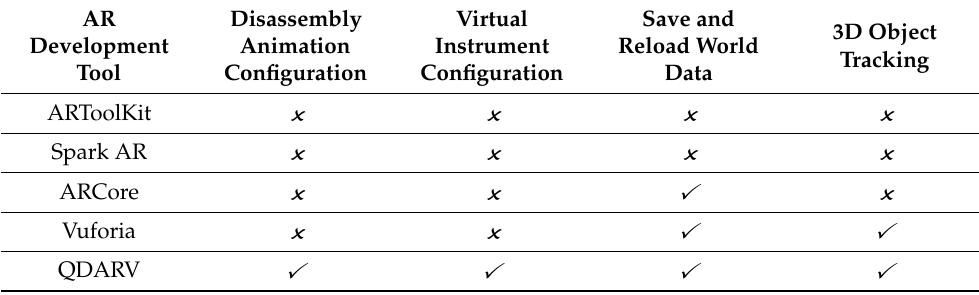
Table 1. Comparison with other AR development tools.